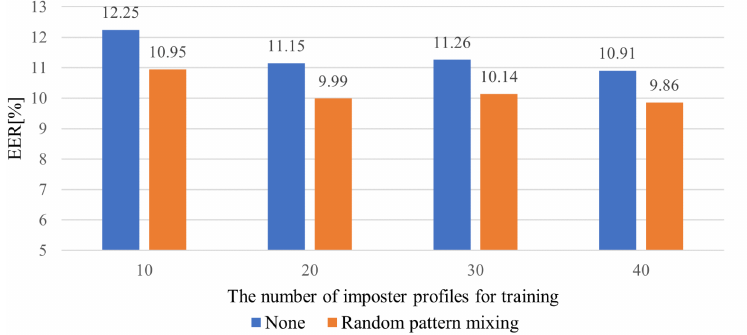
Figure 7. Averaged EERs ( % ) for different numbers of impostor profiles for